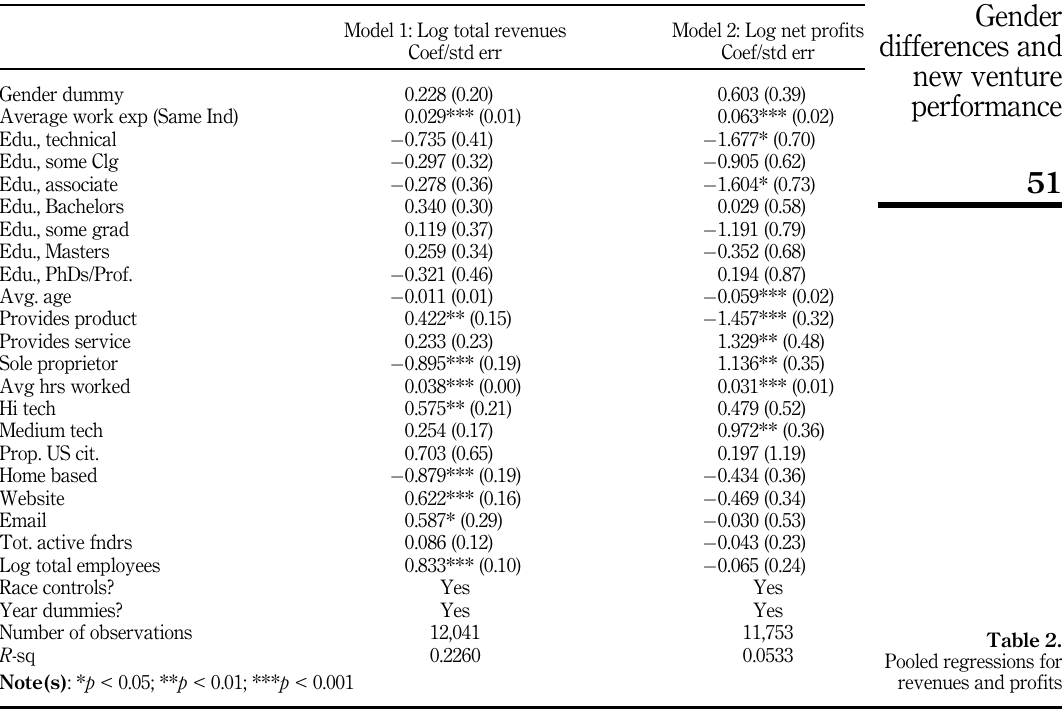
Table 2. Pooled regressions